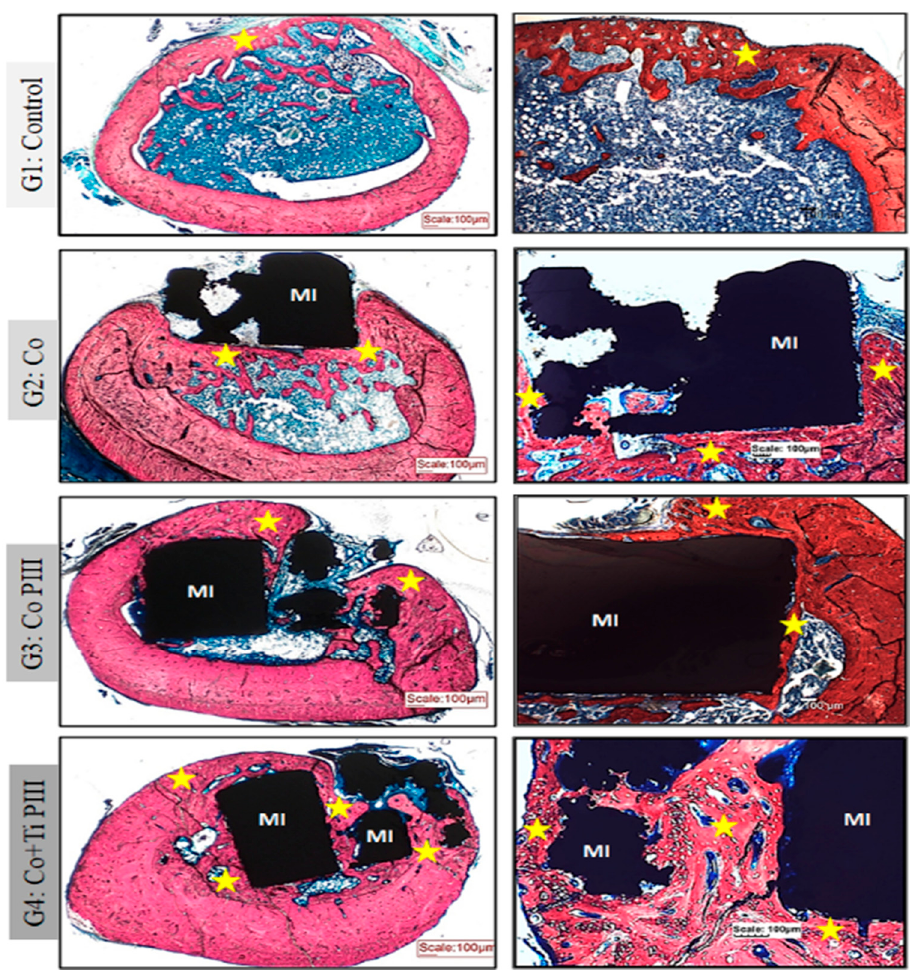
Figure 5. Evaluation of histologic features of defects in the femur bone of rats, Stevens blue stain. Groups: G1: Control—no implant; G2: Co—Co-28Cr-6Mo alloy; G3: Co PIII—Co-28Cr-6Mo alloy with the surface nanostructured by PIII; G4: Co+Ti PIII—Co-28Cr-6Mo alloy with the surface coated